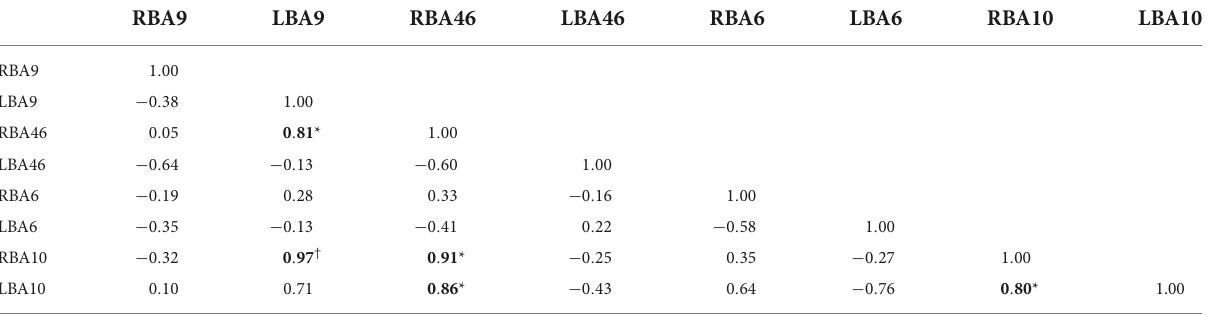
TABLE 9 HbR-based ROIs connectivity analysis—the intervention